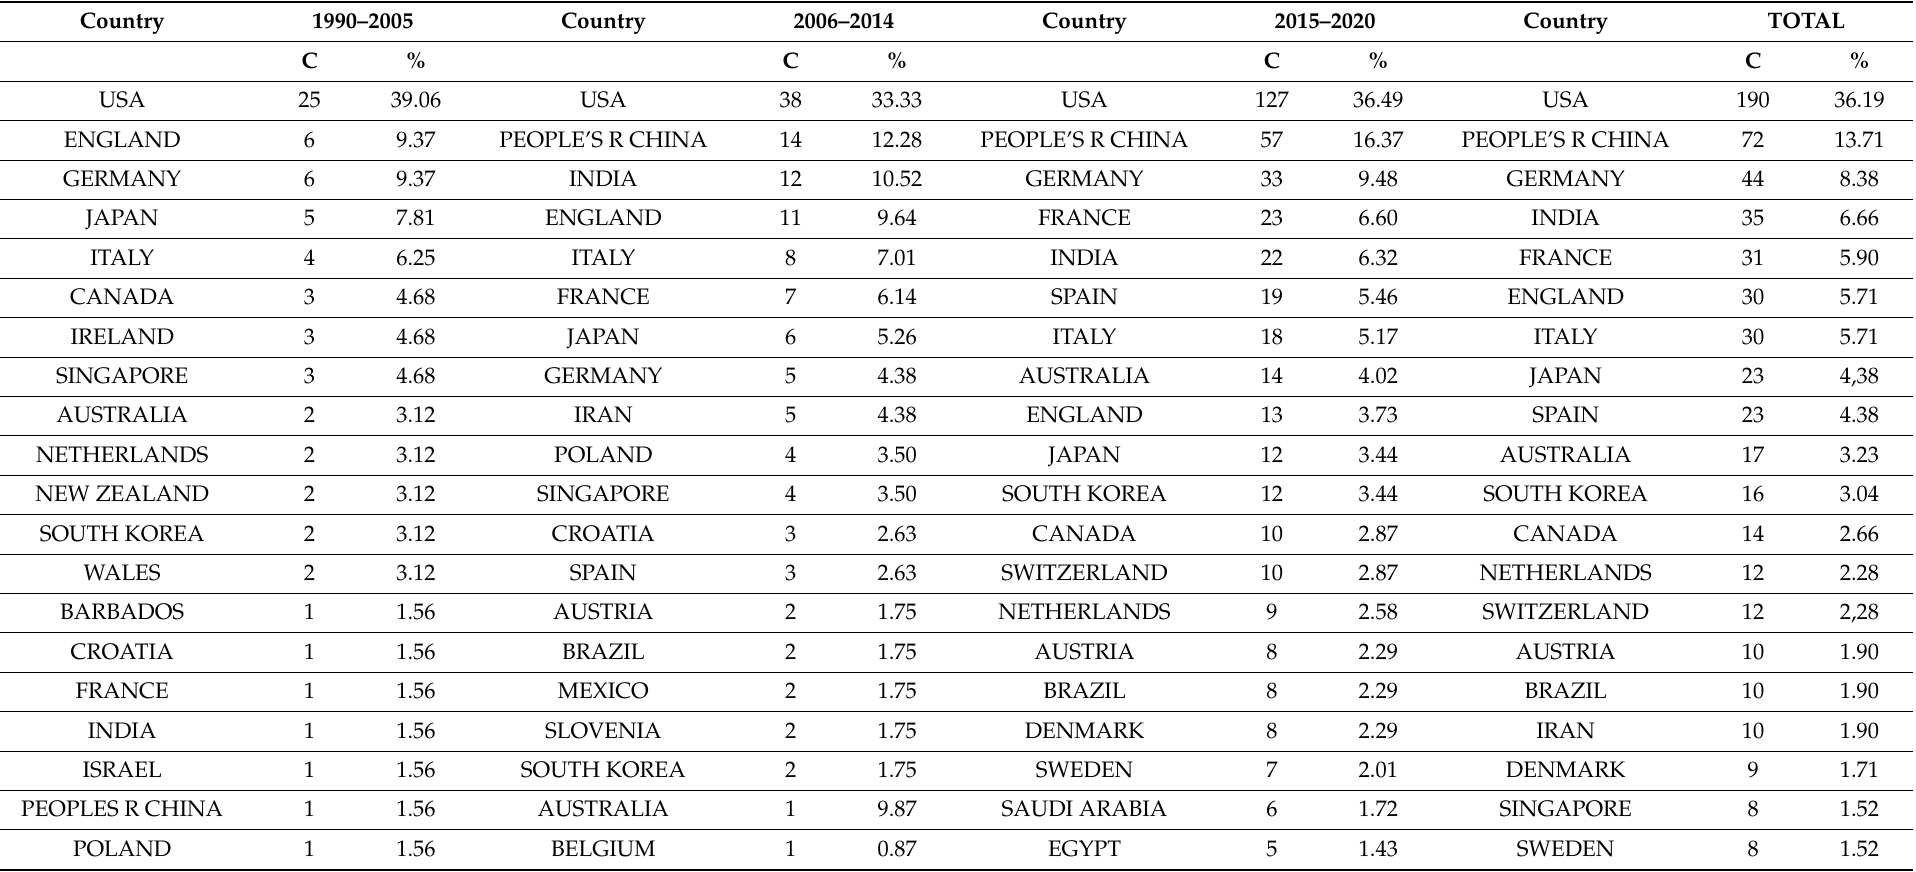
Table 3. Analysis of documents referred to AI and ML applications to diagnostic pathology in lymphoid neoplasms by countries from 1990 to 2020. Data are provided for three subperiods (1990–2005; 2006–2014; 2015–2020) and globally. C: document count; %: percentage of